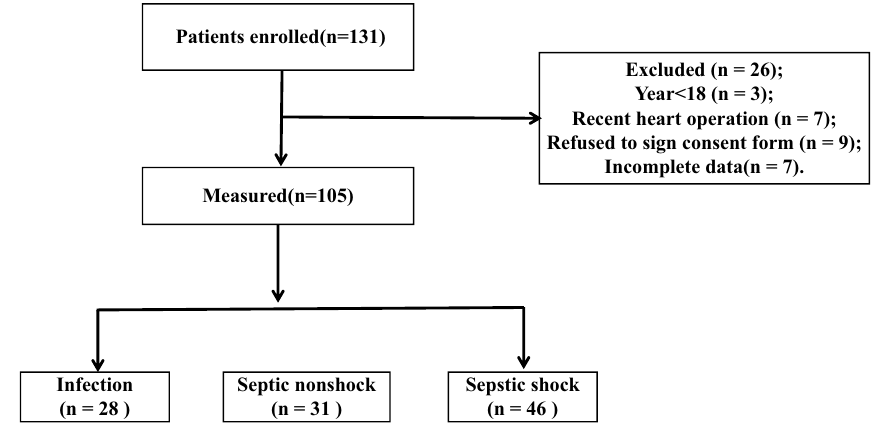
Figure 1. Screening flowchart of patients.